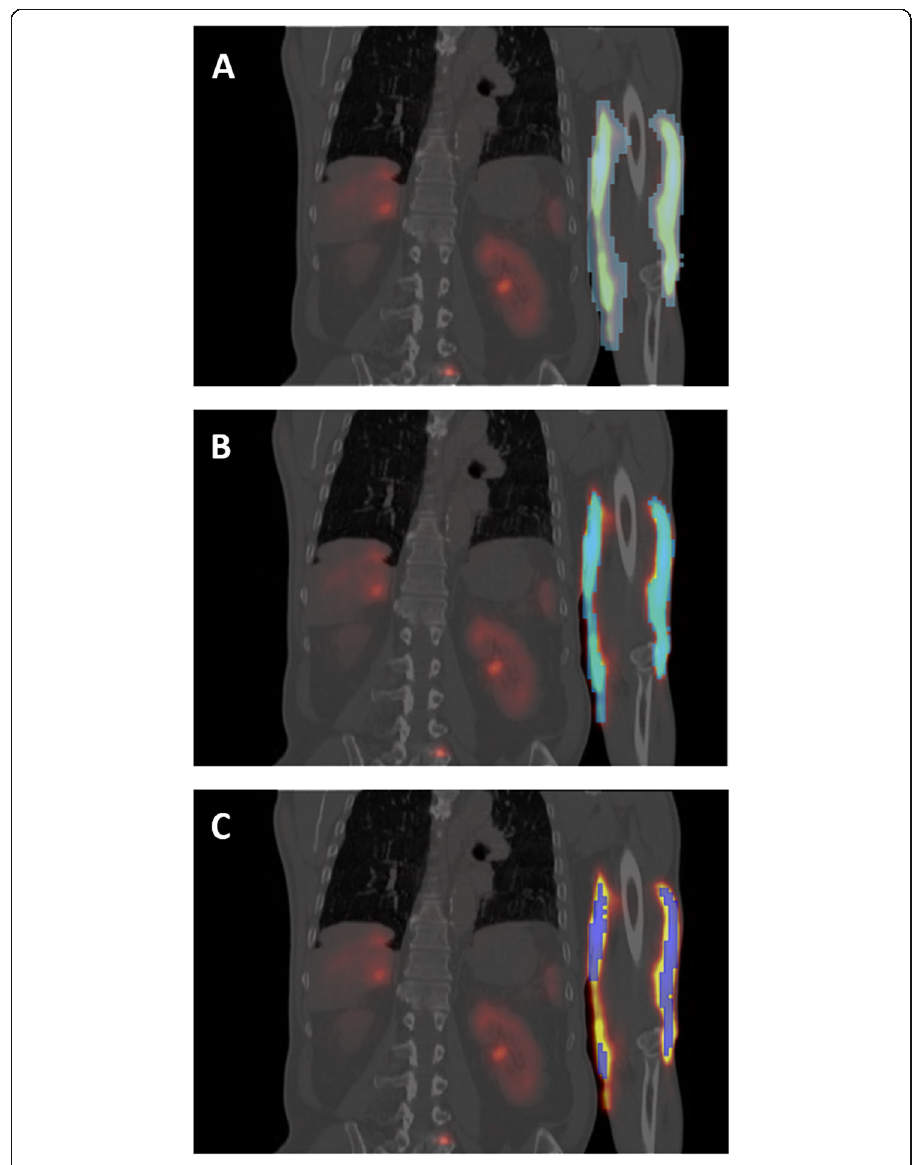
Fig. 8 Coronal slice of T 5h SPECT/CT with superimposed VOI corresponding to 1000 mL ( a ), 400 mL ( b ), and 180 mL ( c )